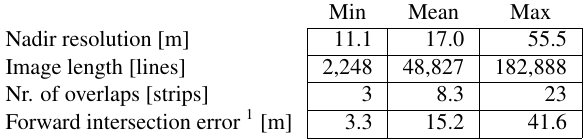
Figure 1: HRSC color orthophoto mosaic (left), color-coded relief map (center), and nadir orthophoto mosaic (right) of MC-11 (East); about 1330 km x 1780 km in size; resolution: 12.5m (nadir mosaic), 50m (DTM, color mosaic); from (Gwinner et al., 2015) Additionally, the illumination conditions change from strip to strip depending on time and season when images are taken. Fur- thermore, the image quality is occasionally degraded by haze and sandstorms, and by oscillations of the spacecraft during image acquisition. Thus, the data set of HRSC strips for each block is very heterogeneous (see also Table 1).